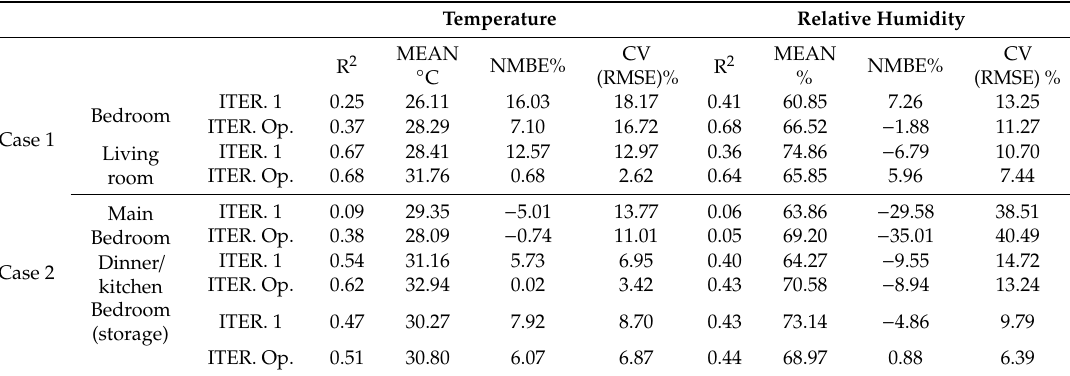
Table 6. Final comparison of level of compliance through checked uncertainty parameters between first iteration (ITER. 1), and optimized iteration (ITER.